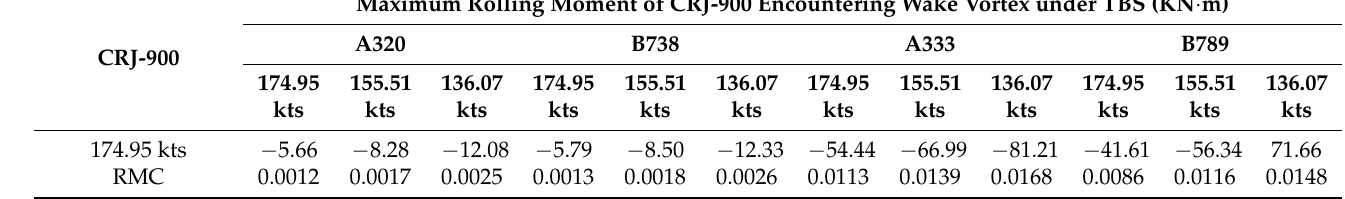
Table 7. Maximum rolling moment of CRJ-900 encountering wake vortex under